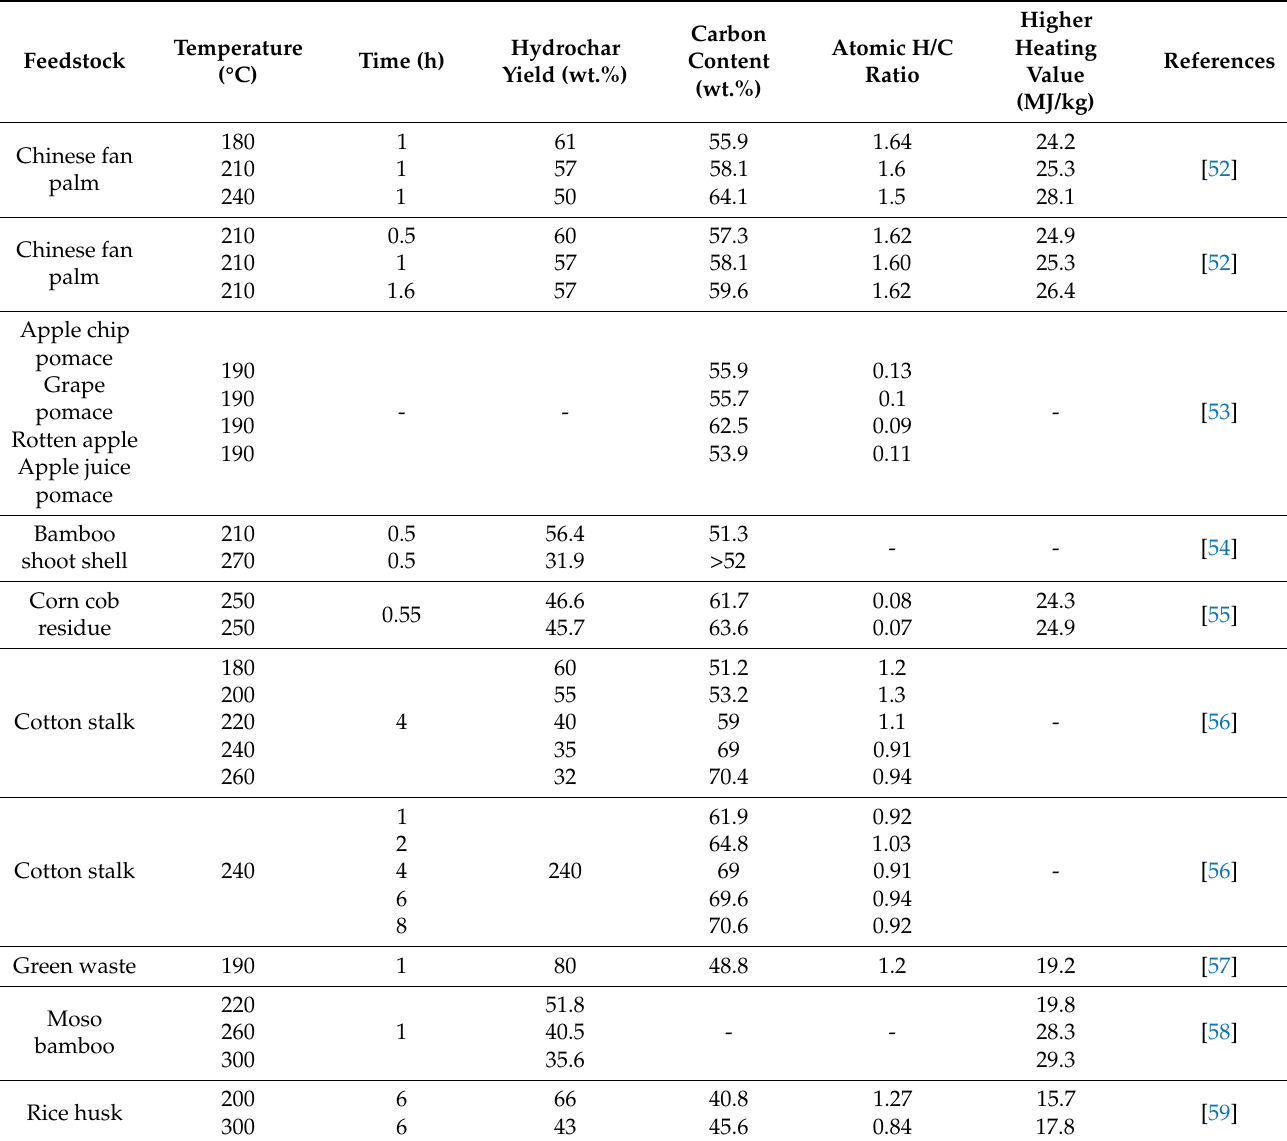
Table 2. Hydrothermal carbonization process to produce hydrochar from different